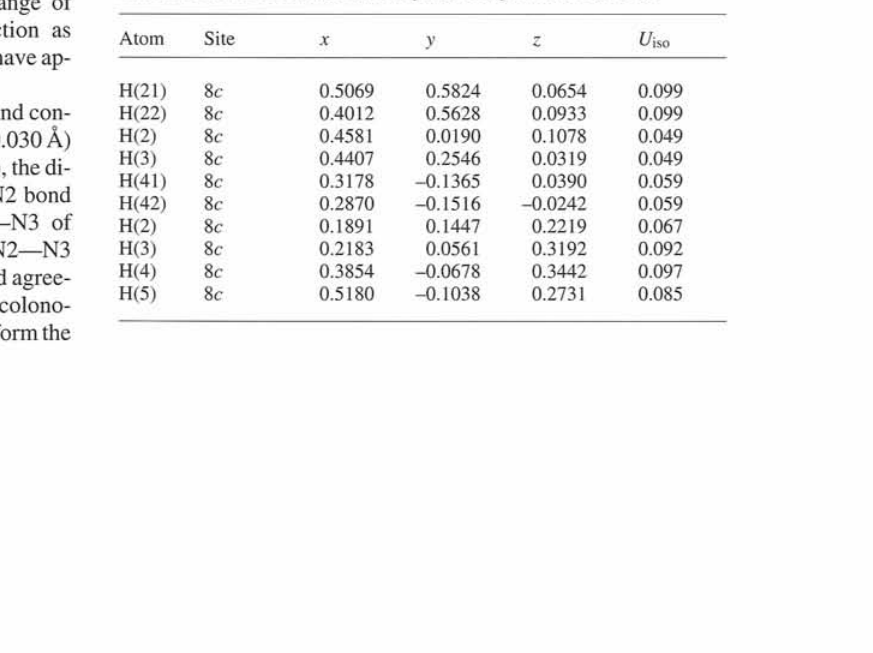
Table 2. Atomic coordinates and displacement parameters (in